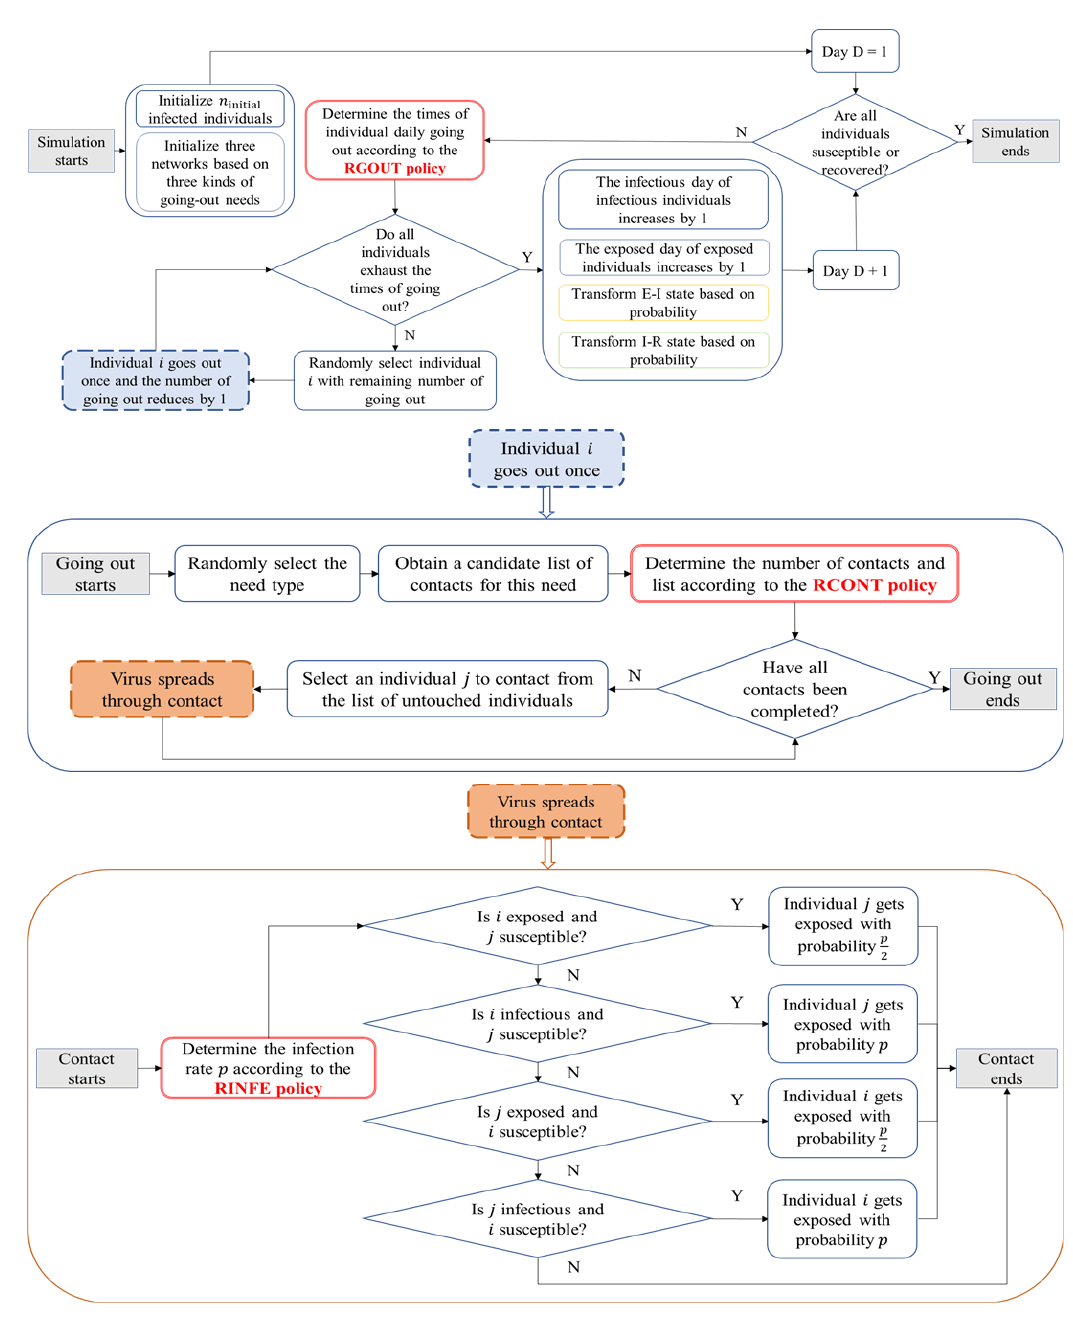
Figure 2. Simulation process.